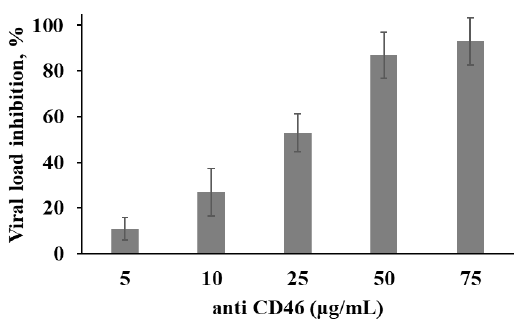
Figure 7. Inhibition of viral load in melanoma cells by mAbs against CD46. Mel Z cell line was incubated with increasing concentrations of mAbs or isotype control mAbs for one hour, washed with PBS and infected with MV at a MOI of 1.0. Viral load was measured in cell lysates by qPCR-RT after 4 h of incubation and the impact of anti-CD46 mAbs was expressed in % relatively to infected cells incubated with isotype control mAbs. The data shown are mean results from three independent experiments; error bars indicate standard deviation.